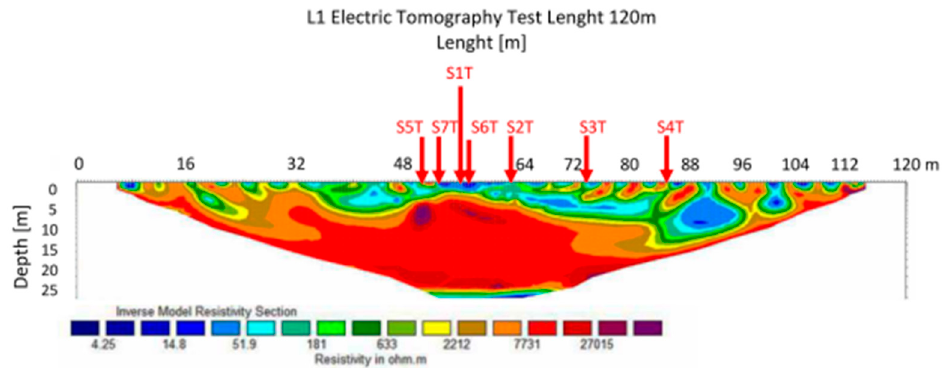
Figure 14. Layout of the Electric Tomography Test and the new boreholes performed in October 2017.